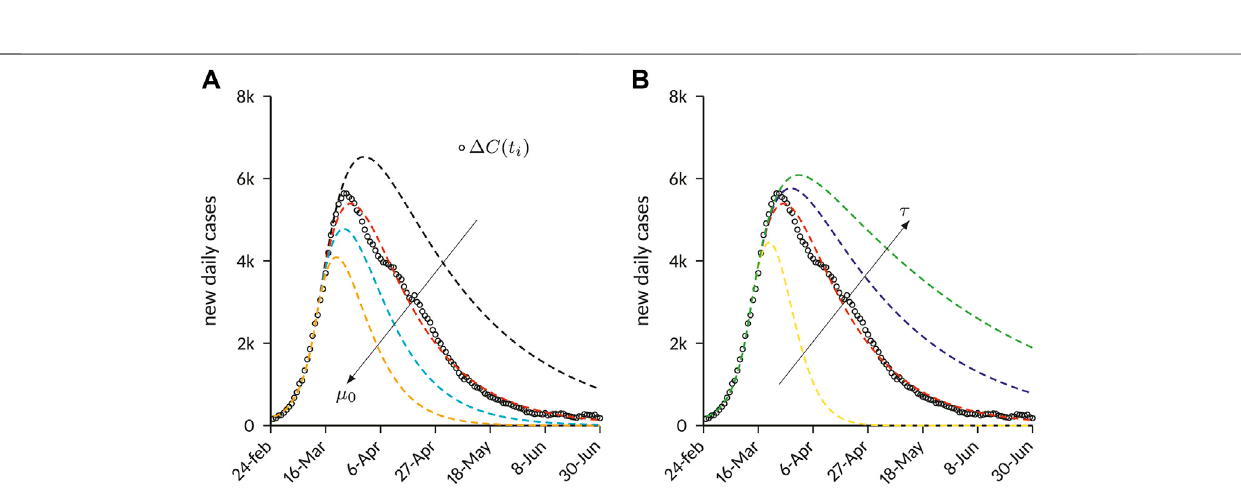
Frontiers in Physics |